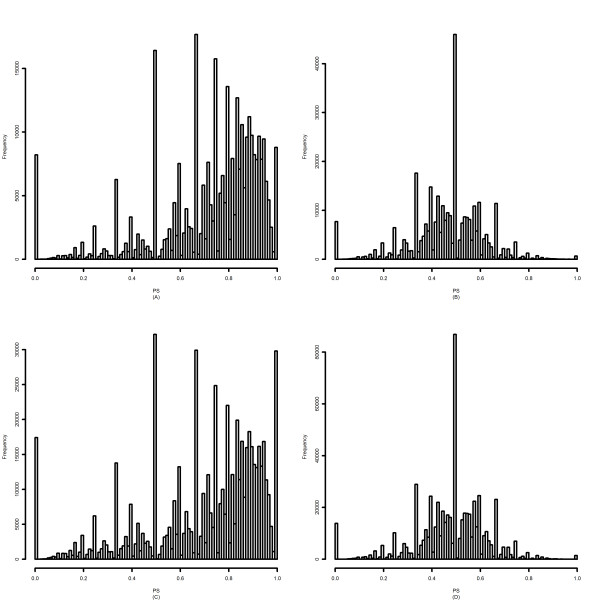
Histogram of PS. (A) Colon cancer dataset, PLIER summarization (mean = 0.725, std = 0.22) (B) Colon cancer dataset, RMA summarization (mean = 0.465, std = 0.148) (C) Human tissue dataset, PLIER summarization (mean = 0.702, std = 0.244) (D) Human tissue dataset, RMA summarization (mean = 0.479, std = 0.148)